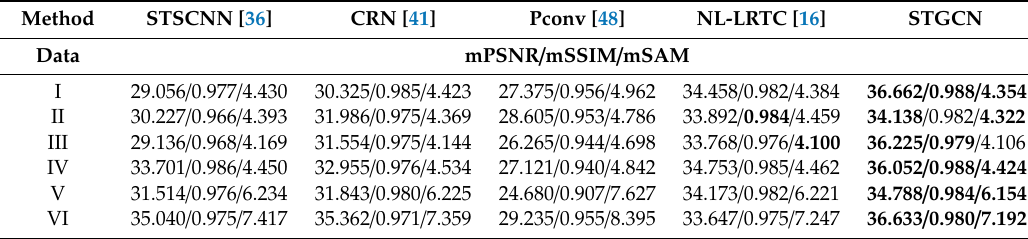
Table 3. Quantitative evaluation of di ff erent algorithms on simulated clouds of each data in the WHU dataset. The best value of each indicator is